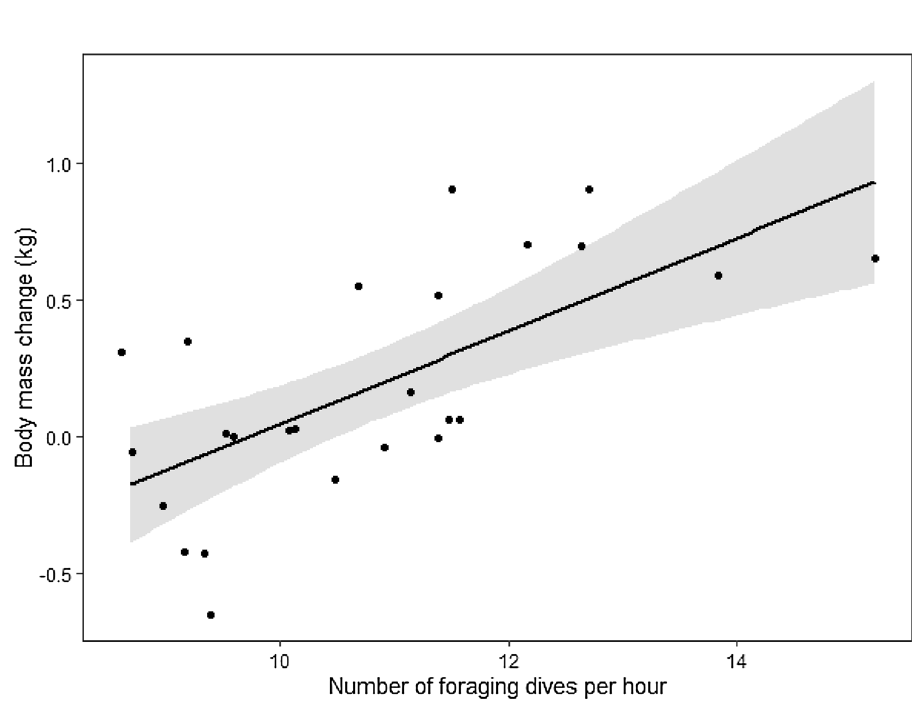
Figure 4. Body mass change of Adélie penguins over a foraging trip increases with the number of foraging dives they perform per hour. Linear regression equation and 95% CI from model 1: y = − 1.658 + 0.170 * Foraging_dives_per_hour ; marginal R 2 =